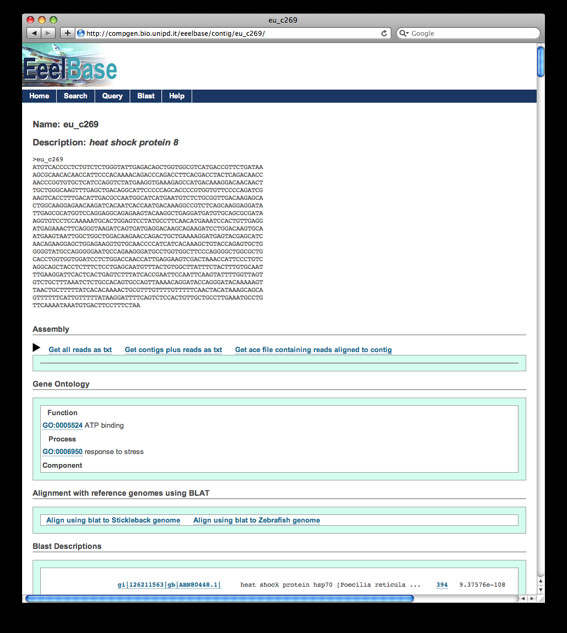
EeelBase screenshots. Example of the "gene-like" entry in the European eel transcriptome database (EeelBase). For each contig, different categories of information are given together with links to additional web pages (e.g. UCSC graphic display of contig alignments with zebrafish genome).